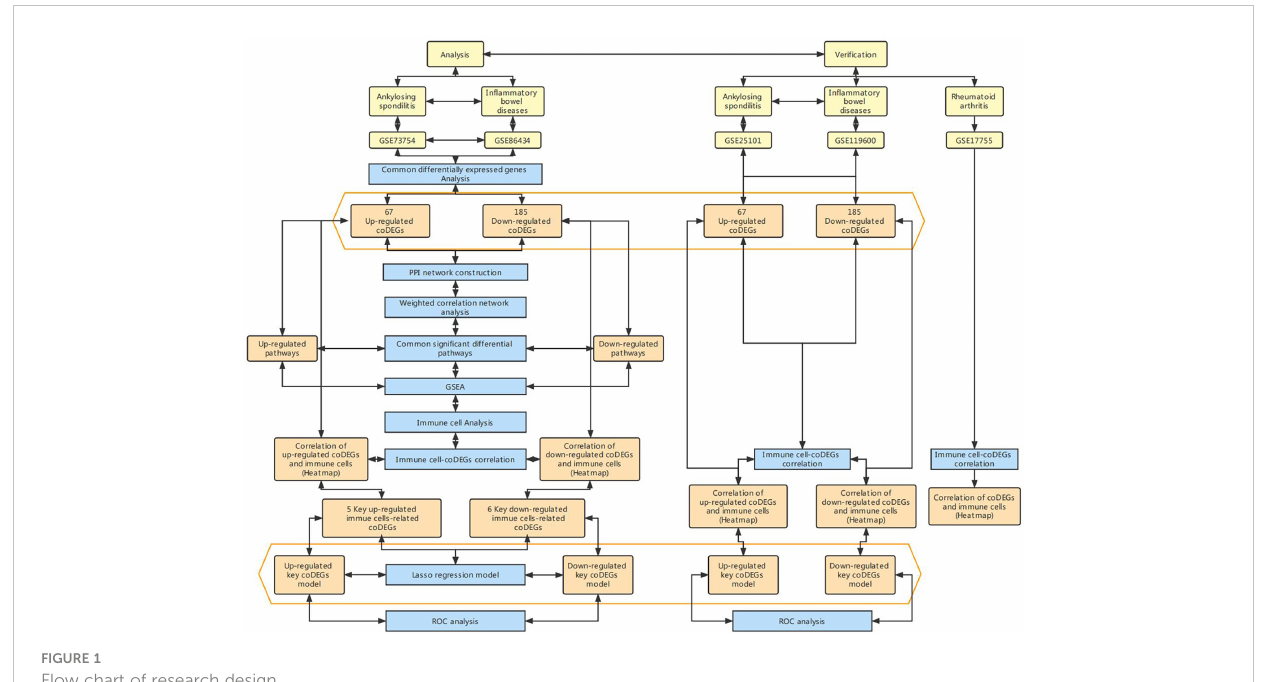
FIGURE 1 Flow chart of research